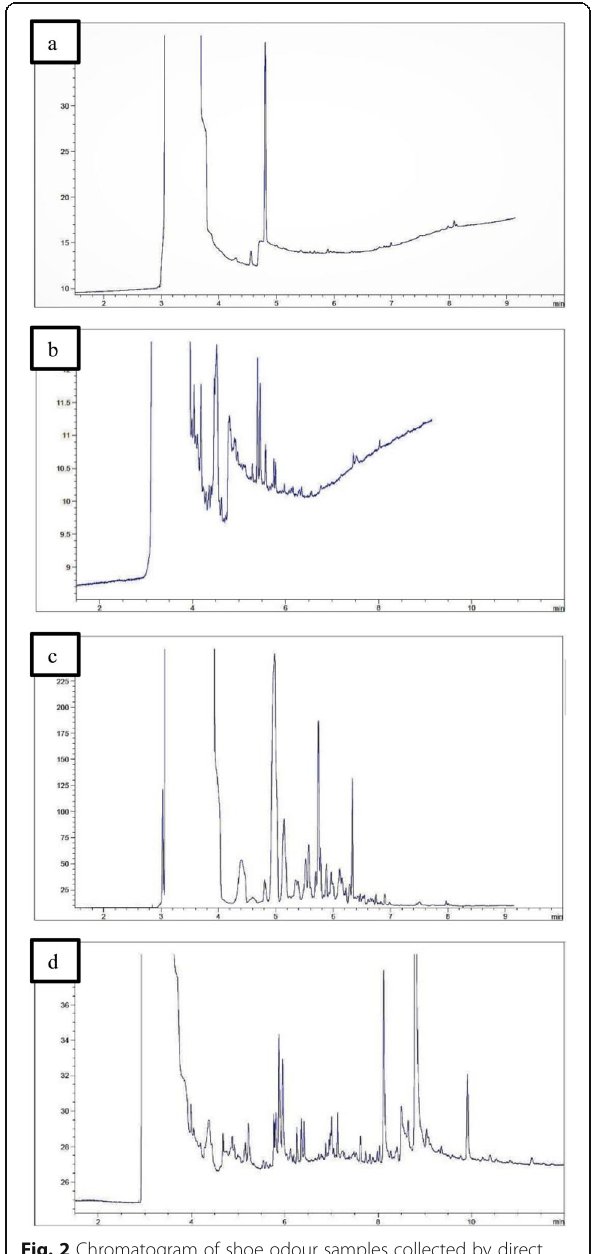
Fig. 2 Chromatogram of shoe odour samples collected by direct solvent extraction methods using four different types of solvents; ( a ) mixture acetone: n-hexane, ( b ) n-hexane, ( c ) acetone and ( d )